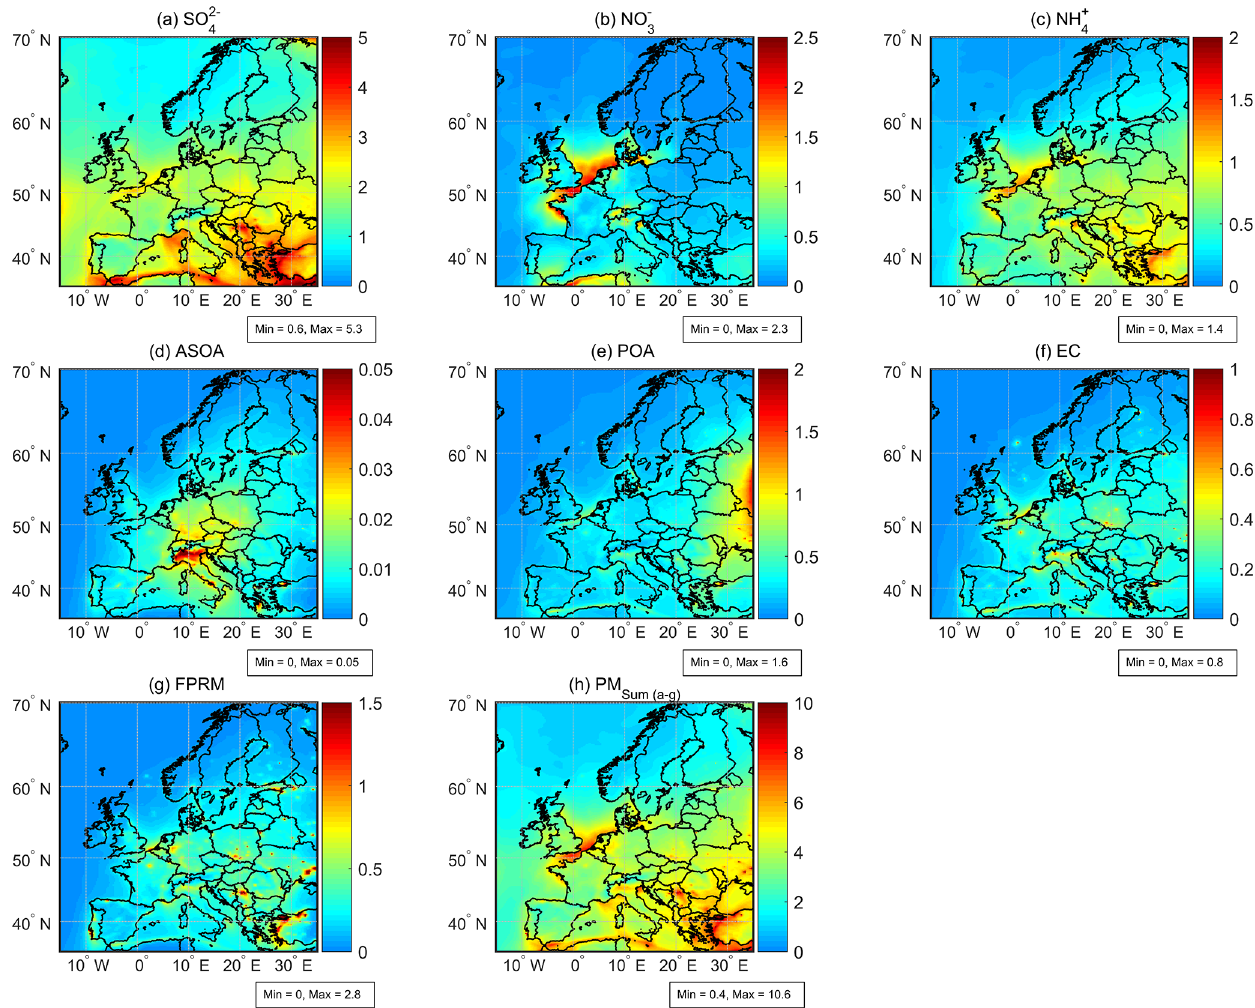
Figure 3. Seasonal daytime (10:00 − 18:00LMT) mean concentrations (µgm − 3 ) of (a) sulfate (SO 2 − (NH + ), (d) anthropogenic secondary organic aerosol (ASOA), (e) primary organic aerosol (POA), (f) elemental carbon (EC), (g) fine other 4 primary aerosols (FPRM) and (h) sum of panels (a–g) , for the BASE scenario in summer